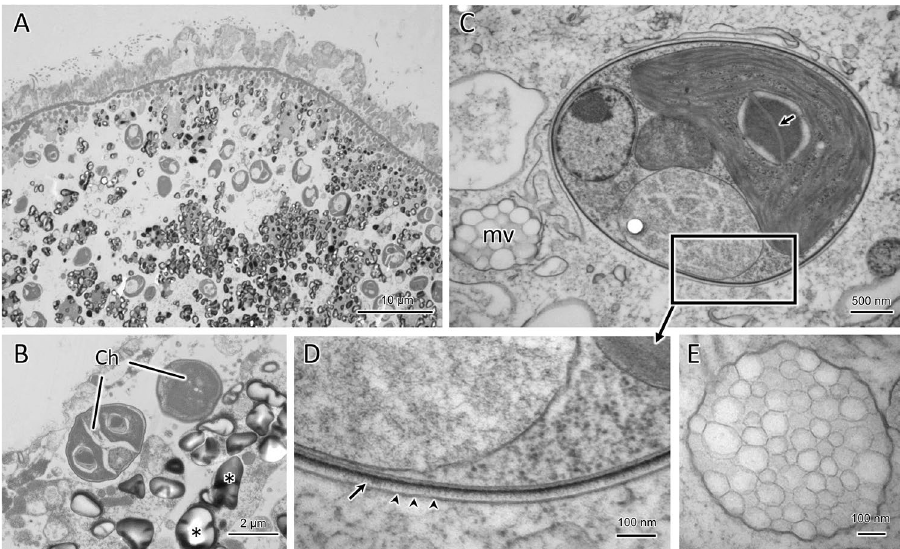
Figure 3. ( A ) and ( B ). Chemically-fixed specimen of S. pyriformis . The cytoplasm was observed as highly vacuolated, in which symbiotic Chlorella cells (Ch) were observed to be scattered in a large vacuole without being covered by individual surrounding membranes. Chlorella at the lower left is a rarely seen dividing organism. Many small electron-dense granules of 1–2 μm in size were present in the cytoplasm. ( C )–( E ) S. Quick-frozen and freeze substituted specimen of S. pyriformis . The cytoplasm was not vacuolated, and each symbiotic Chlorella was surrounded by a symbiosome membrane (arrowheads in D ). The symbiosome membrane was closely opposed to the cell wall surface by a distance of less than 50 nm. The cell wall surface of the symbiotic Chlorella was ornamented by fluffy filaments (arrow). In the symbiotic Chlorella , the pyrenoid structure was penetrated by thylakoid membranes (arrow in C ), characteristic of the genus Chlorella . ( D) is an enlarged view of the area indicated by the rectangle in ( C ). In the cytoplasm, many multi-vesicular bodies of about 1 μm in diameter with unknown function were observed (mv in C and also in E